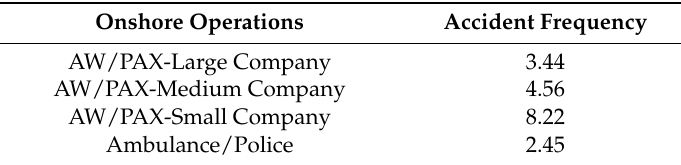
Table 4. Accident frequency with personal injuries per 100 000 flight hours among aerial work/PAX operators of different company size, 2005–2012 ( N =